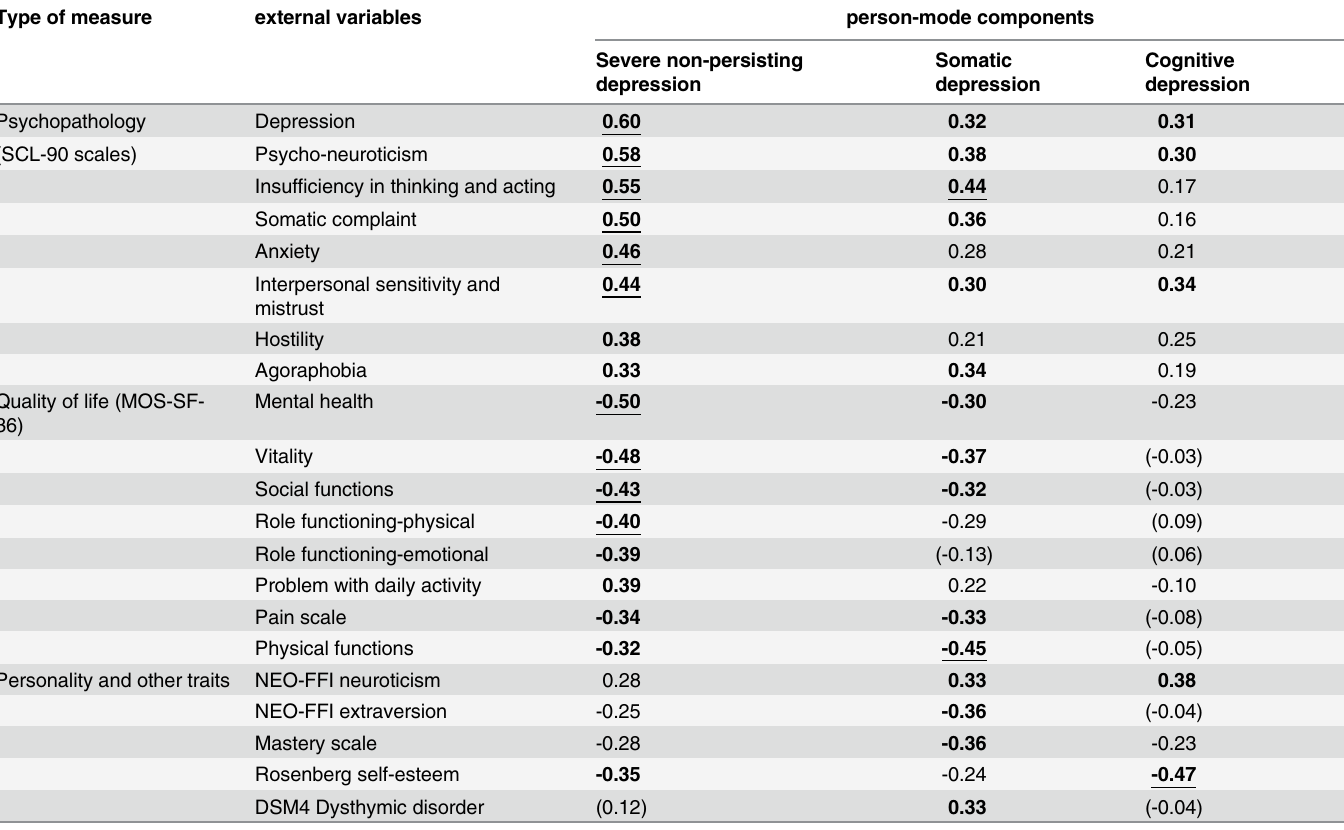
Table 5. Pearson correlations between the person-mode component scores and baseline variables. SCL-90 = Symptoms Checklist-90; MOS-SF36 = Medical Outcome Study Short Form 36; NEO-FFI = Neuroticism, Extraversion, Openness Five-Factor Inventory. All correlations had